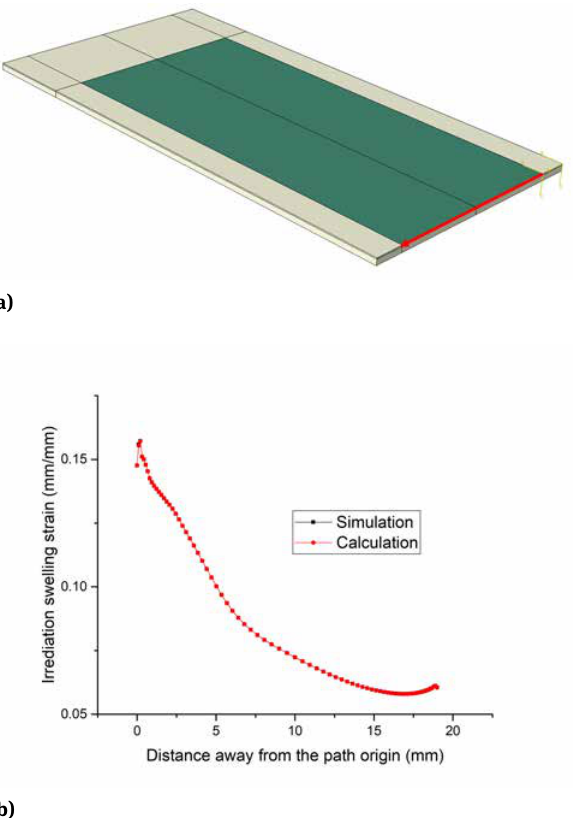
Figure 8: Verification of irradiation swelling strains where, ¯ ε t + ∆t is output by ABAQUS. The theoretical results p of ¯ σ t + ∆t are calculated through nonlinear iterative solution of Eq. (55)